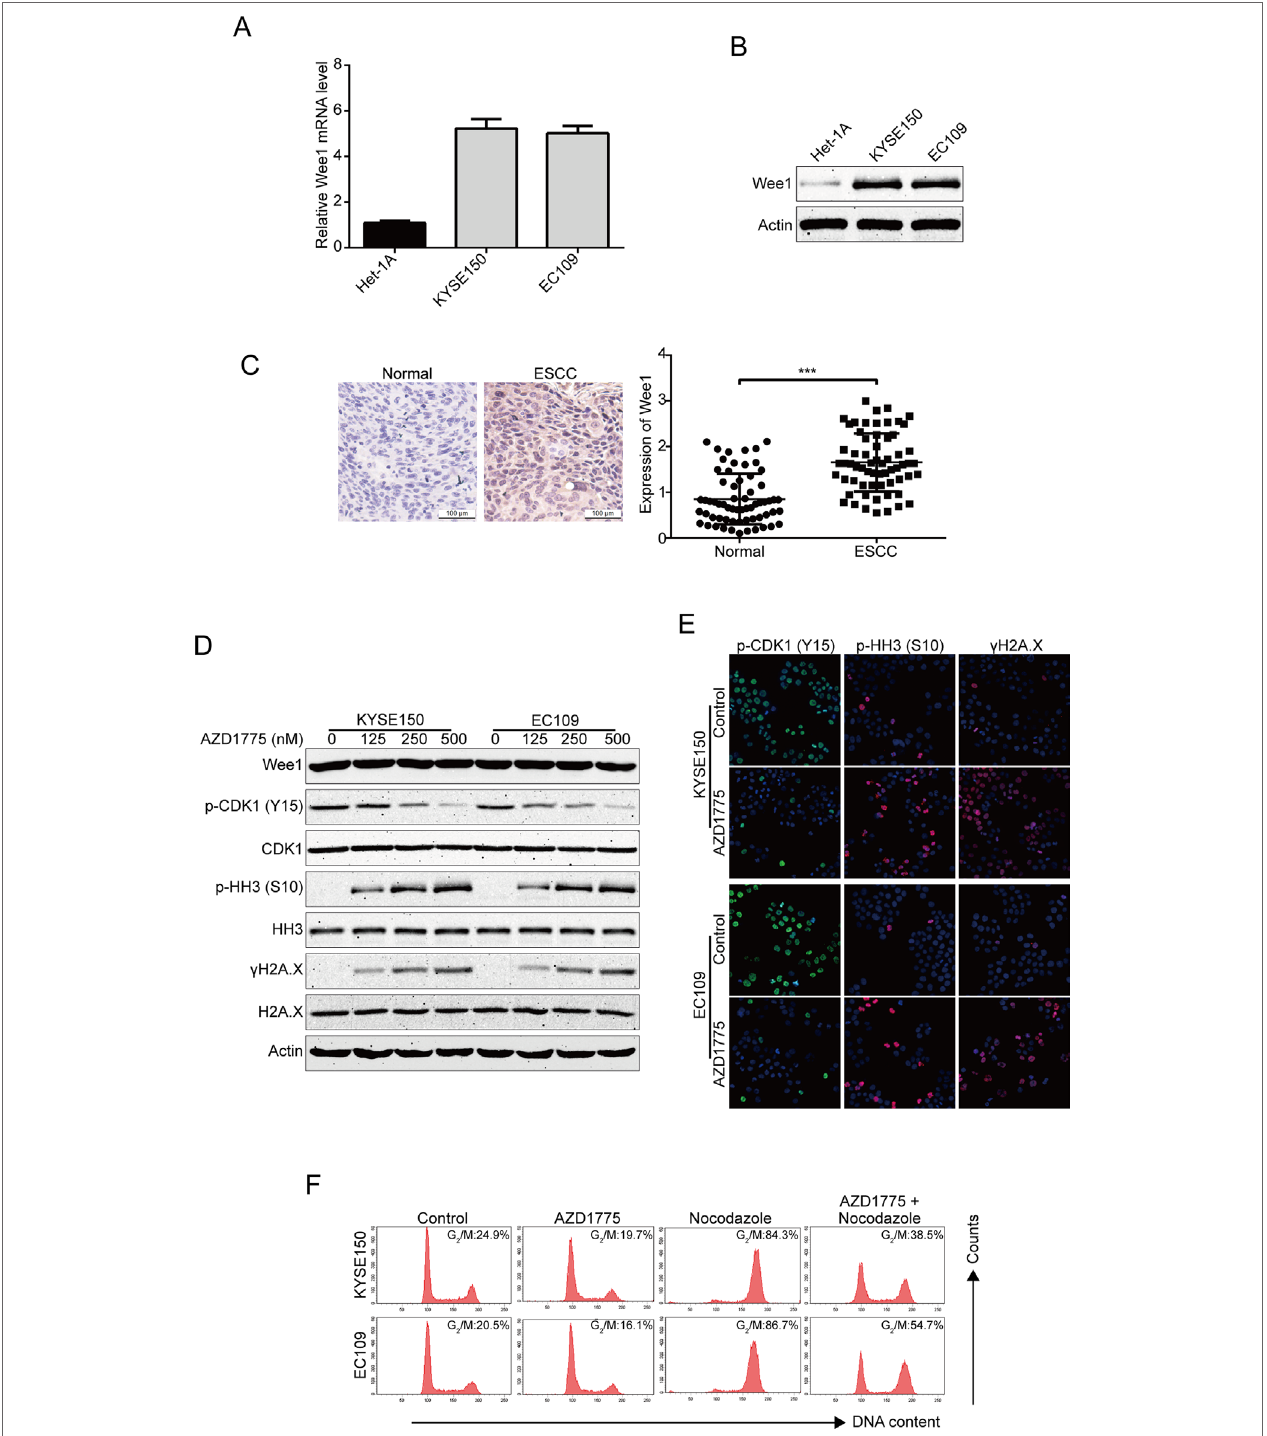
FIGURE 1 | AZD1775 inhibits the activities of Wee1 kinase in ESCC cells. (A) qRT-PCR was used to detected the mRNA levels of Wee1 in one immortalized esophageal epithelial cell line (Het-1A) and two ESCC cell lines (KYSE150 and EC109). (B) The basic protein level of Wee1 were examined by Western blotting analysis. (C) Representative IHC micrographs ( left ) and summary bar chart ( right ) of Wee1 protein expression in ESCC tissues (63 pairs of ESCC cases and the matched adjacent normal tissues). Scale bars, 100 μm . (D, E) ESCC cells were treated with increasing concentrations of AZD1775 for 24 h, Western blotting (D) and immunofluorescence staining (E) were used to detect the protein levels of phospho-CDK1 (Y15), phospho-histone H3 (S10) and γ H2A.X. (F) KYSE150 and EC109 cells were treated with or without nocodazole (10 ng/ml) for 8 h, followed by 250 nM AZD1775 treatment for another 16 h. The cells were then collected, fixed, and analyzed by flow cytometry after staining with PI. * P < 0.05 by Student’s t